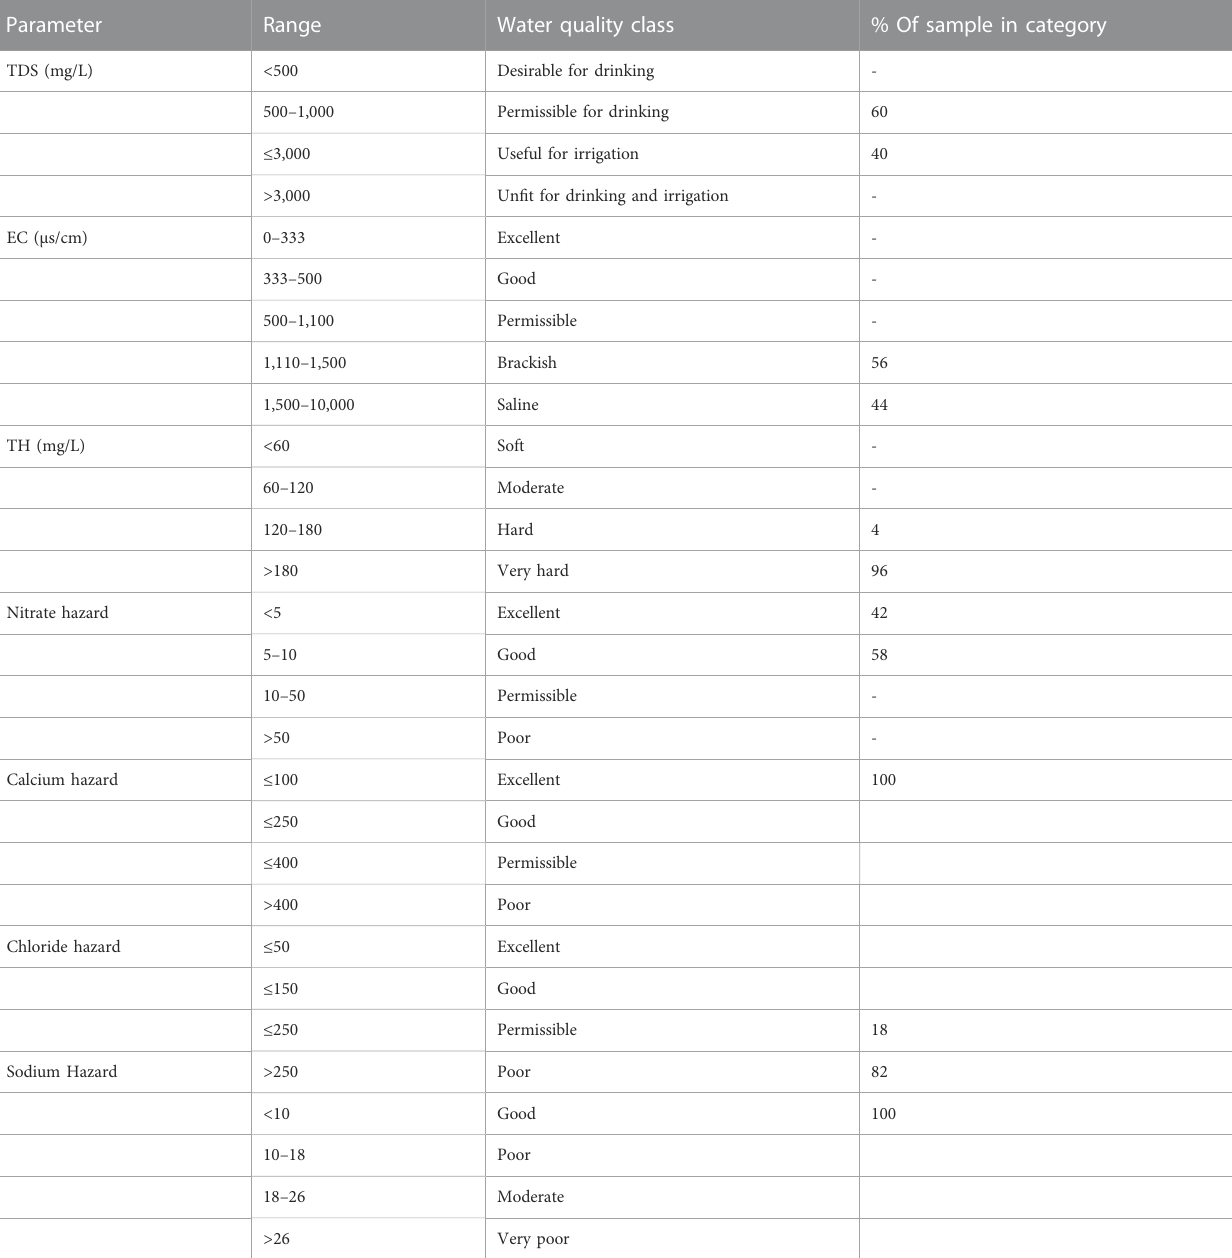
TABLE 4 Classi fi cation of all groundwater samples based on physicochemical characteristics (Modi fi ed after Langenegger, 1990; Davis and De Wiest, 1966; McGowan, 2000).